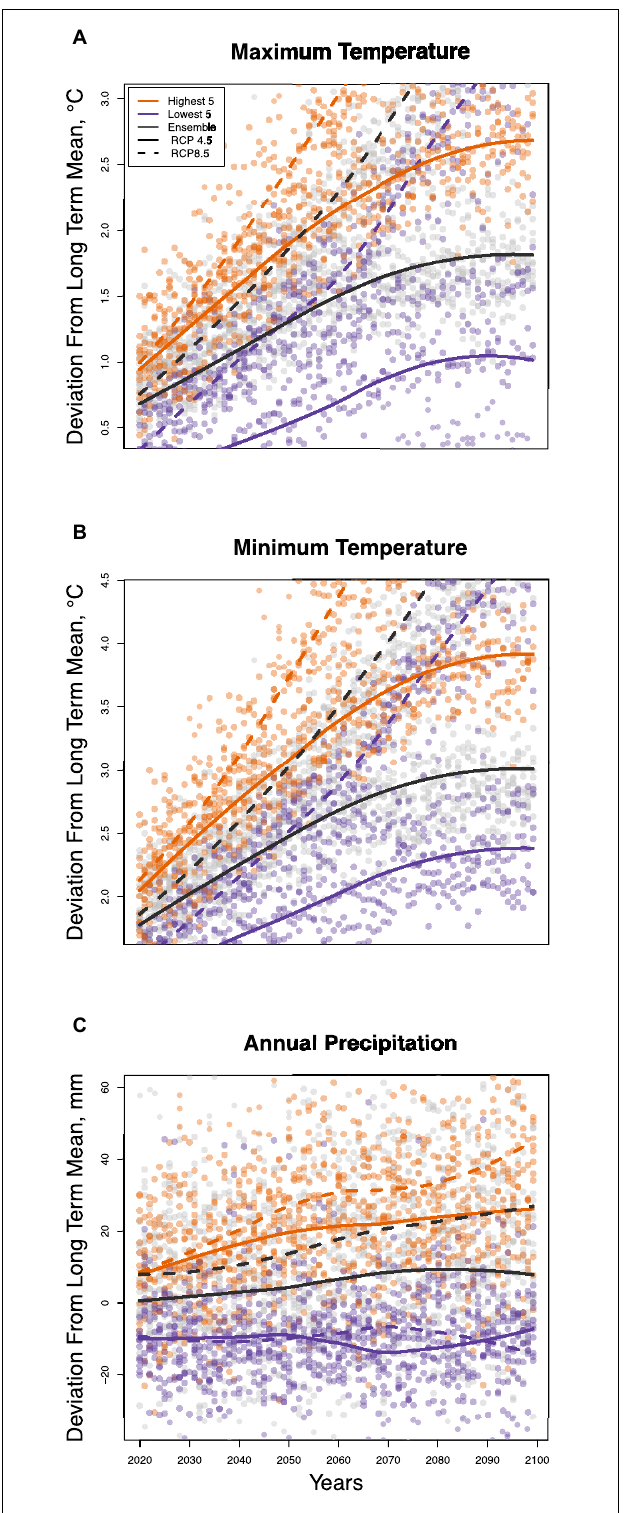
FIGURE 2 | A comparison of average predicted maximum temperature (A) , minimum temperature (B) , and precipitation (C) in Gabon from the highest temperature increase models (orange), lowest five models (purple), and all model ensembles (gray) for RCP 4.5 (solid lines) and RCP 8.5 (dashed lines).